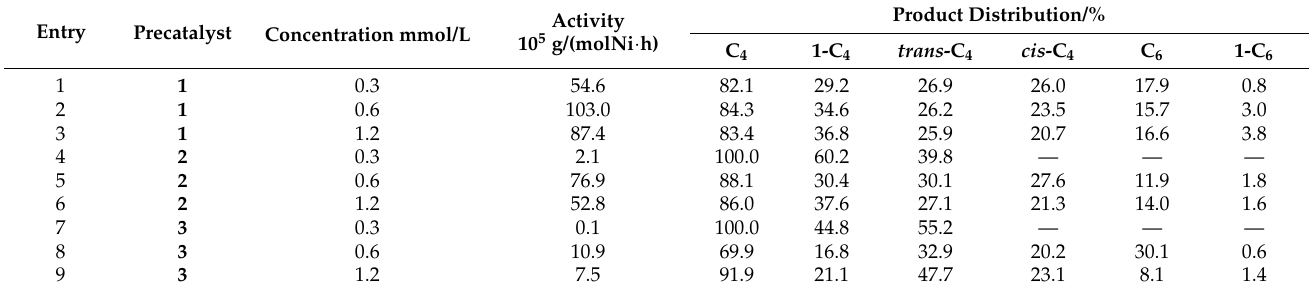
Table 3. Effects of the precatalyst’s concentration for precatalysts 1 – 3 on ethylene oligomerization a